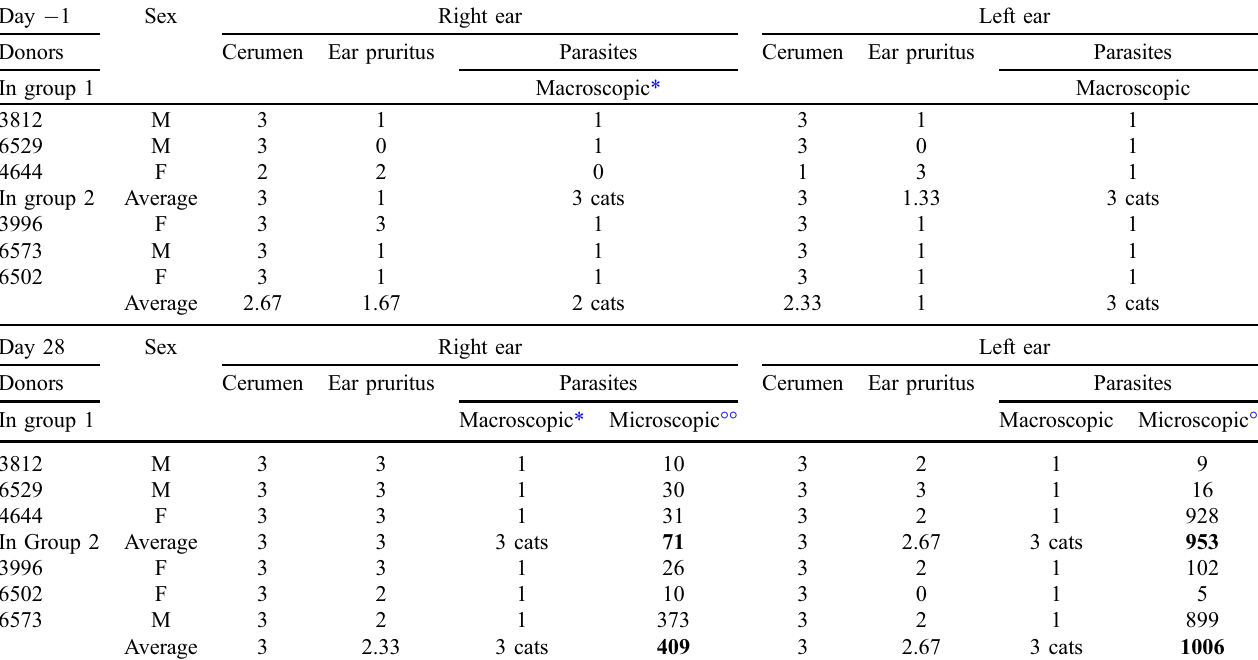
Table 2. Ear mite infestation and clinical status in donor cats. Day (cid:2) 1